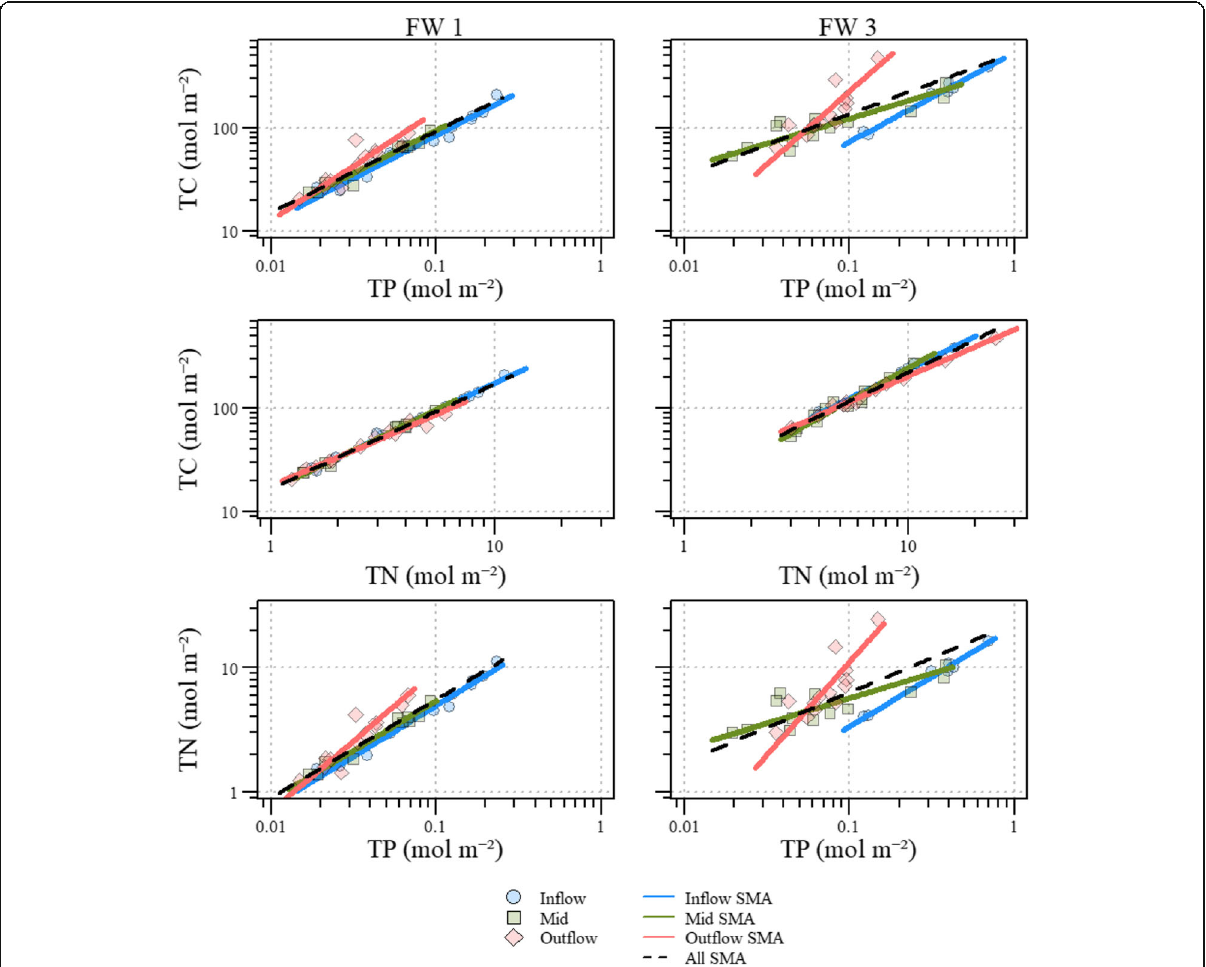
Fig. 5 Stoichiometric relationships between total carbon (TC), total phosphorus (TP), and total nitrogen (TN) in the soil ecosystem compartment for Stormwater Treatment Area 2, flow-ways (FWs) 1 and 3. Inflow, mid, outflow, and overall standardized major axis (SMA) regressions indicated by lines through the data. Values can be converted to mass per volume (i.e., milligram per kilogram) concentration by multiplying each value by its respective conversion factor (C = 12.01; N = 14.00; P =